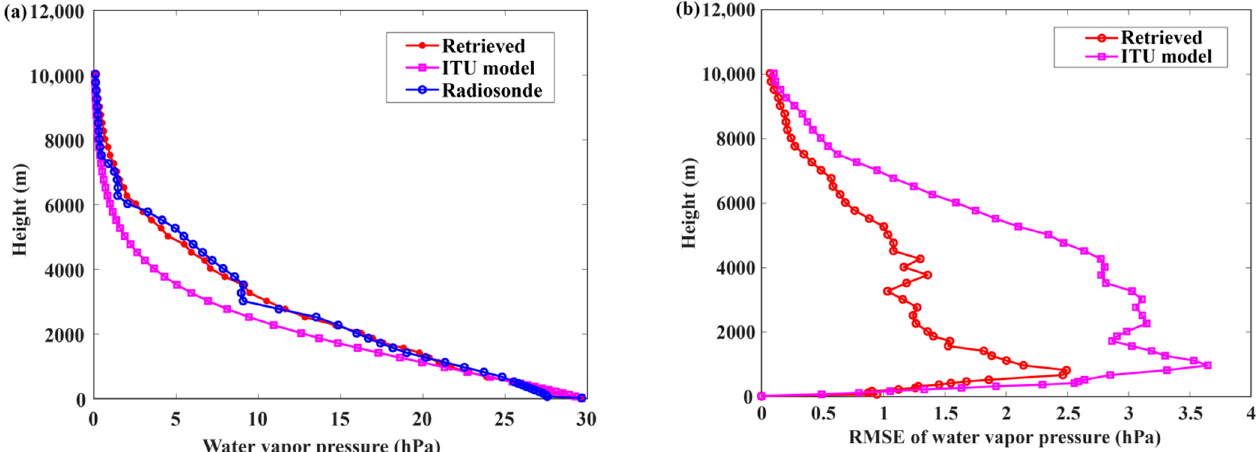
Figure 6. ( a ) The comparison between the retrieved, ITU model and radiosonde profile of water vapor pressure; ( b ) The root mean square error of retrieved and ITU model profile of water vapor pressure.